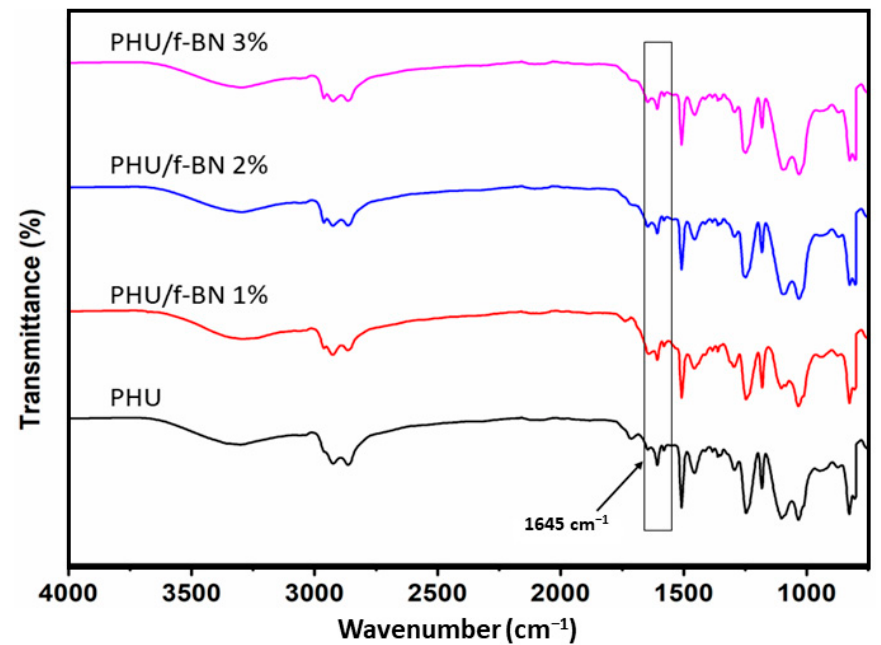
Figure 3. ATR-FTIR of different PHU films.